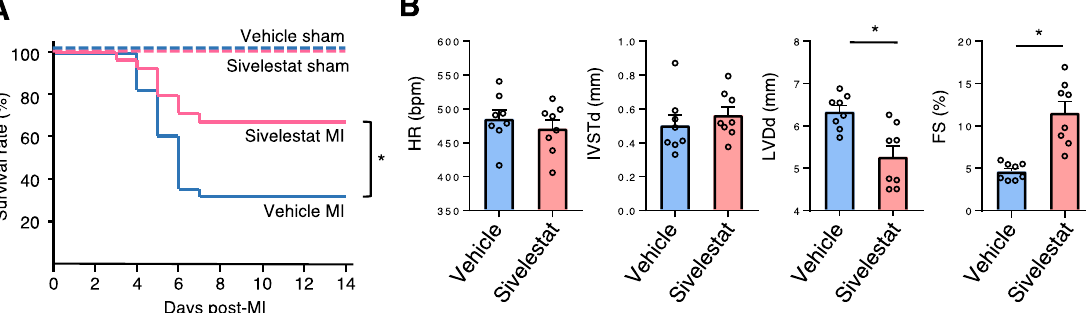
Figure 6. Sivelestat improved survival and cardiac function post-MI. ( A ) Kaplan–Meier survival analysis 14 days post-MI treatment with sivelestat or vehicle. Blue line indicates vehicle treatment with MI ( n = 28), red line indicates sivelestat treatment with MI ( n = 24), dotted blue line indicates vehicle treatment with sham operation ( n = 5), and dotted red line indicates sivelestat treatment with sham operation ( n = 7). * p < 0.05 by log rank. ( B ) Bar graphs represent echocardiographic parameters from the indicated mice. Results are presented as mean ± SEM, n = 8 each, * p < 0.05.